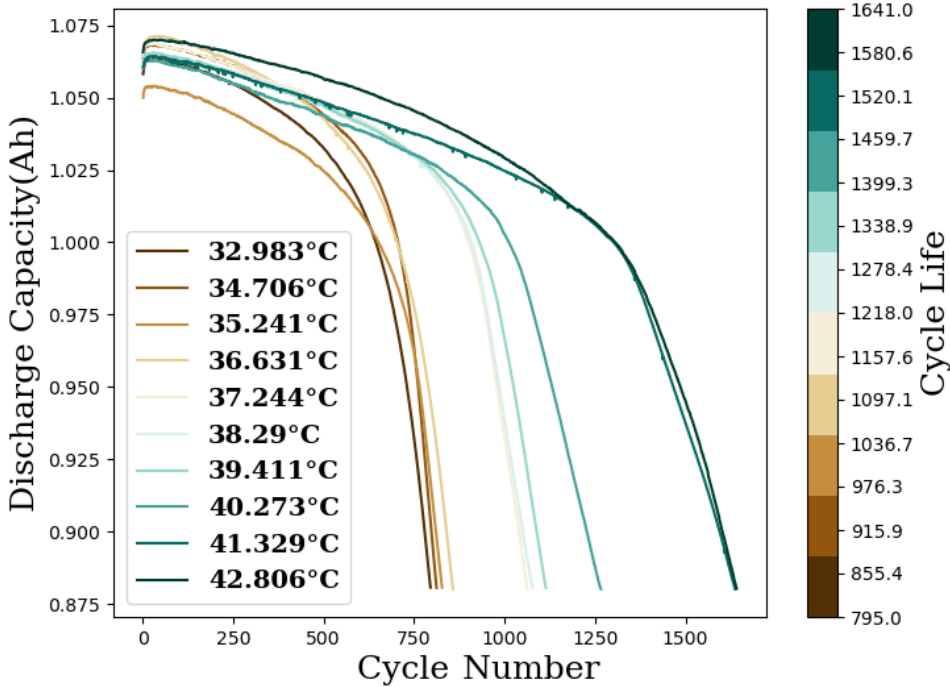
Figure 8. Discharge capacities of exemplary cells for different final testing temperatures. All cells started cycling with similar temperatures, but cells with longer cycle lives presented higher final testing